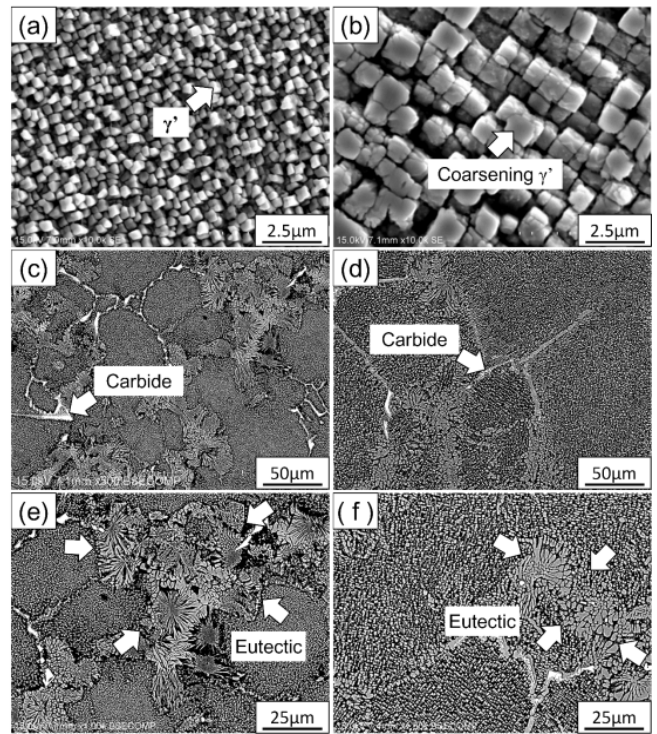
Figure 1. Microstructure of as ‐ cast CM247LC before or after the HIP process: ( a , b ) are γ′ s, ( c , d ) are carbides, and ( e , f ) are eutectics. Here, ( a , c , d ) are obtained before the HIP process, while ( b , d , f ) are obtained after the HIP process.